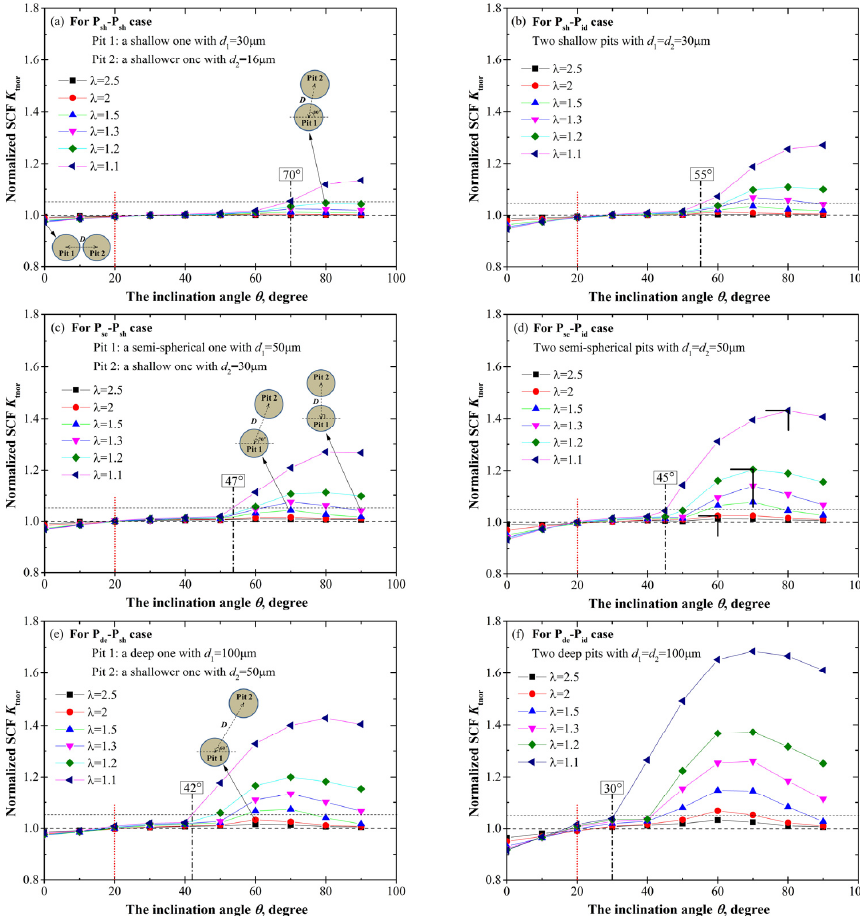
Figure 7. The variation of K tnor with the relative position parameters λ and θ for two adjacent pits. ( a )